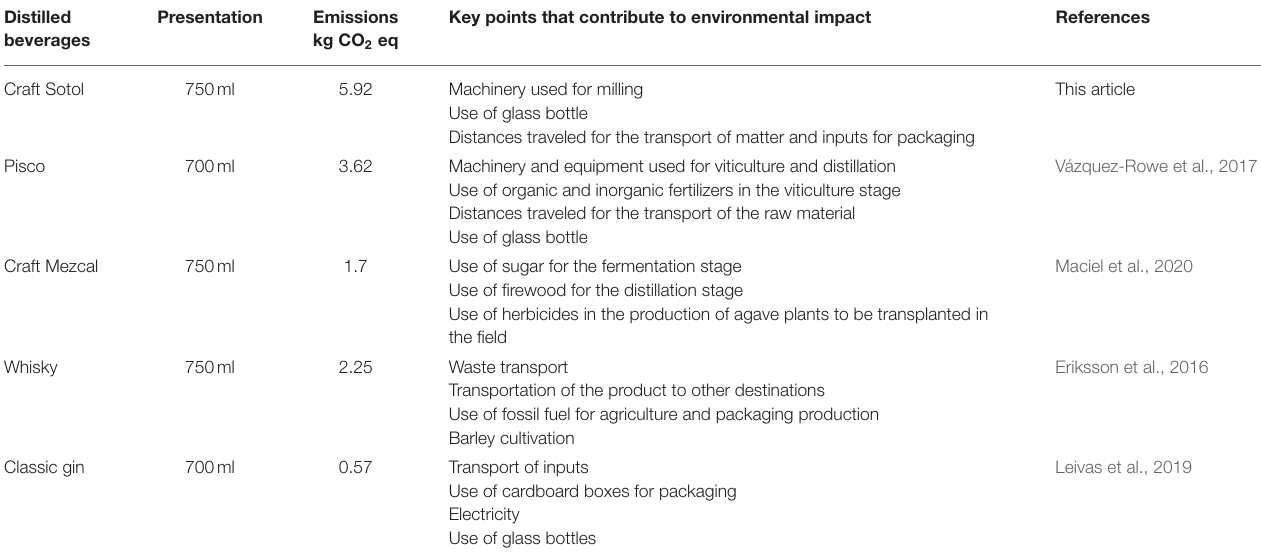
TABLE 4 | A comparison of the results of this study with previous research